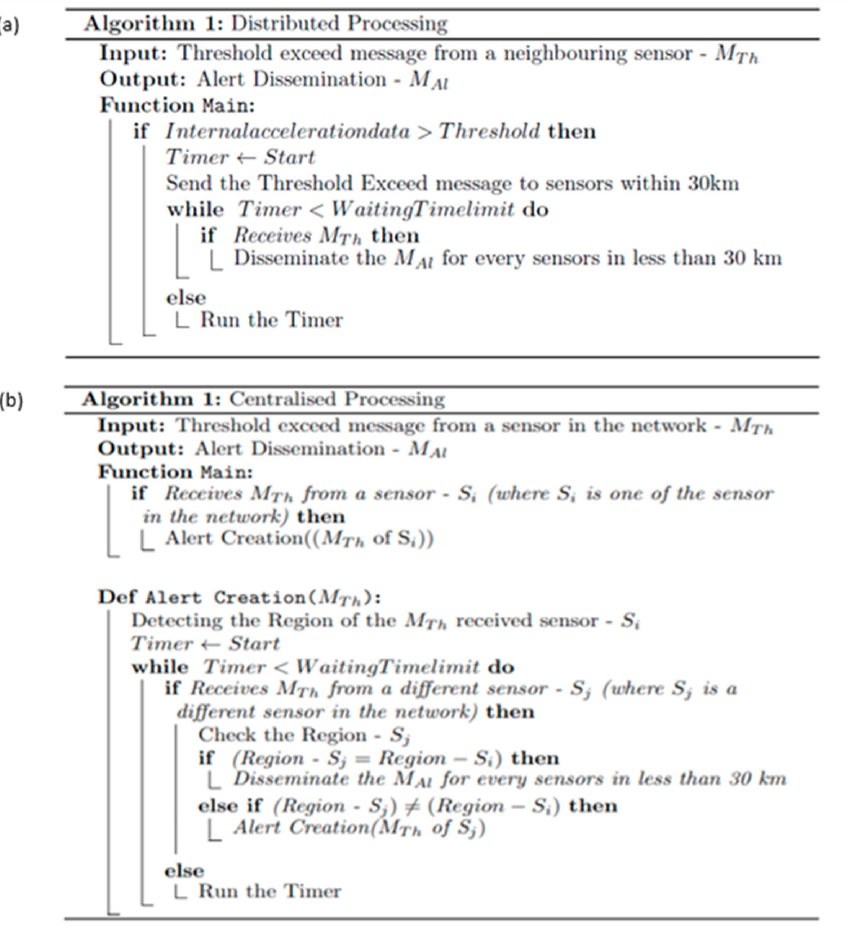
Figure 8. ( a ) Pseudocode for the decentralised processing algorithm. ( b ) Pseudocode for the central ‐ ised processing algorithm. tralised processing